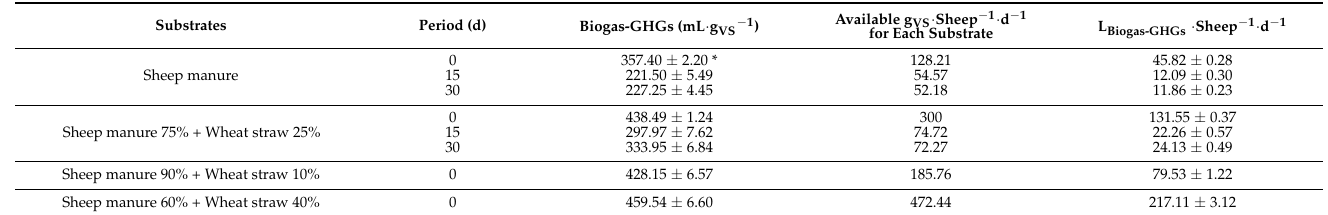
Table 5. Estimation of GHG emissions expressed as biogas potential based on the availability of organic carbon during anaerobic digestion of substrates.